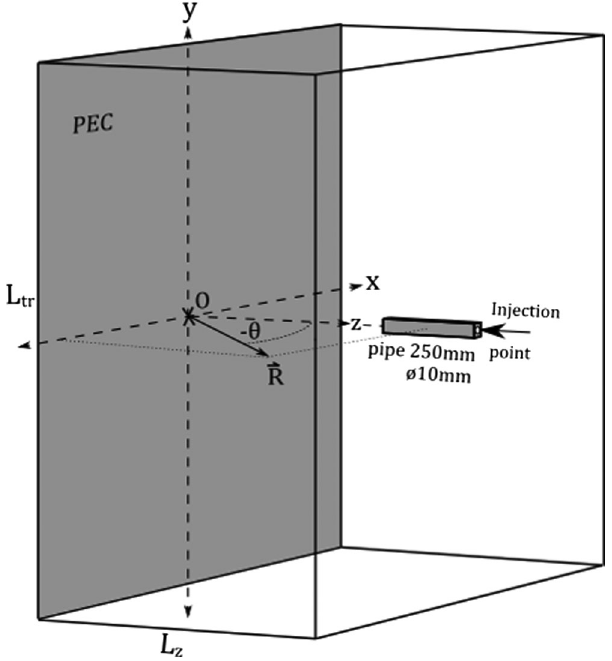
FIG. 8. The simulation